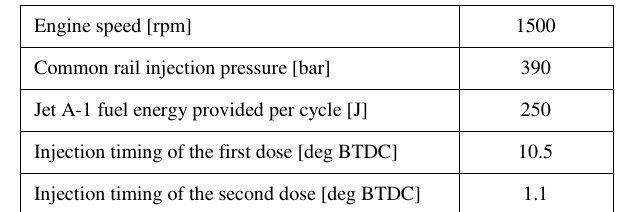
Fig. 6. Pressure diagrams (a) and heat release diagrams (b) for different engine load and constant engine speed (1500 rpm) for dual fueling with very early injected Jet A-1 and propane (HCCI